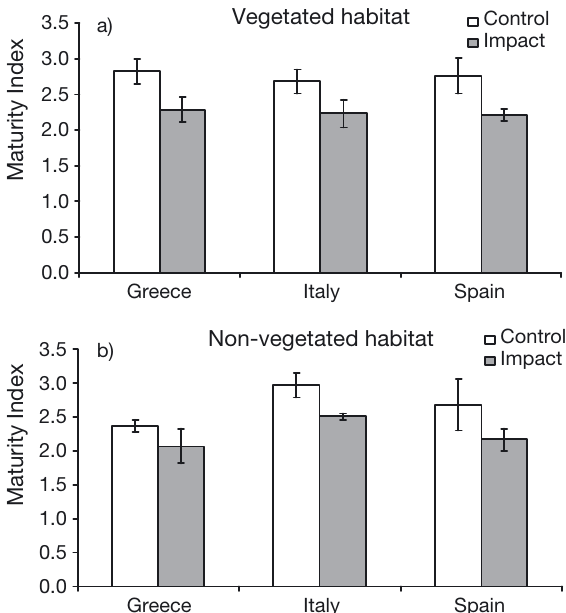
Fig. 2. Maturity index calculated on nematodes in control and impact (fish-farm) sediments in (a) non-vegetated and (b) vegetated habitats. Error bars represent